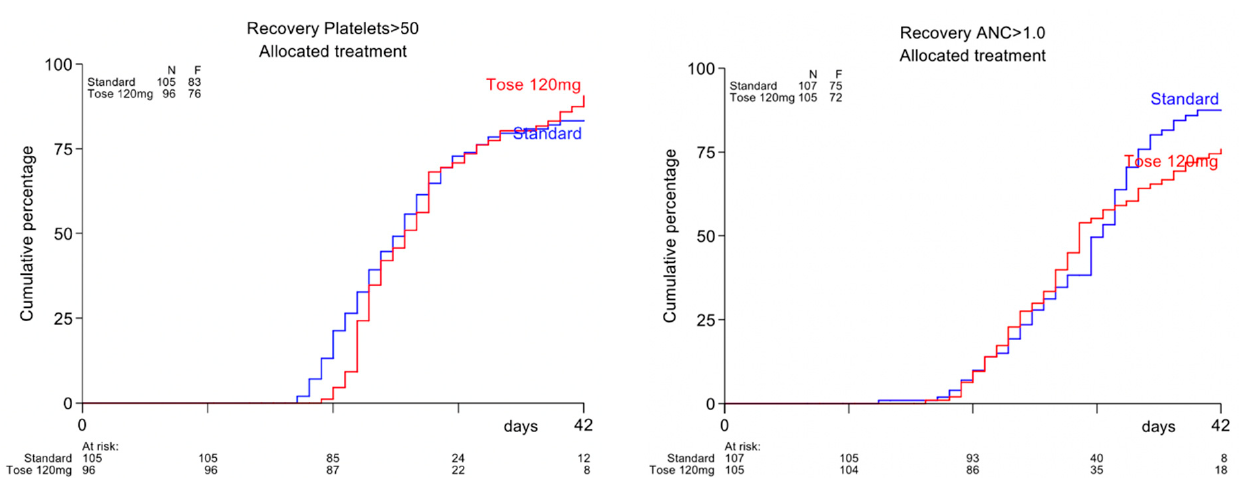
Figure 3. ( a ) Recovery time after cycle 1 to absolute neutrophil count > 1.0 × 10 9 /L ( b ) Recovery time after cycle 1 to platelets > 50 × 10 9 /L.